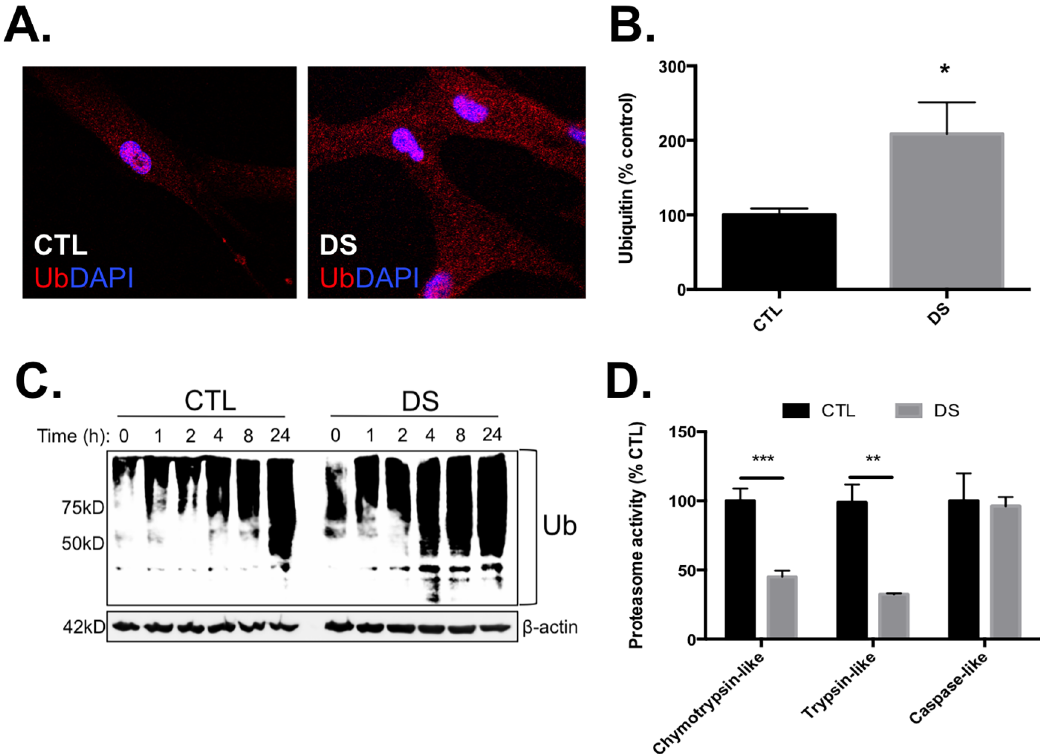
Fig 8. DS cells display an increasedabundance of ubiquitinated proteins and impaired proteasomal function. Untreatedfibroblasts from DS and CTL were stained for ubiquitinatedprotein and visualizedusing fluorescent microscopy (A). The amount of basal ubiquitinstaining was found to be significantly increasedin DS fibroblasts comparedto CTL (B), indicatingincreasedload of misfoldedproteinsin DS cells. Western blot analysesafter treatment with the proteasomal inhibitor,MG132 (5 μ M), show a more rapid increasein polyubiquitinated proteins (C) in DS comparedto CTL. Further investigation of proteasomal activity demonstrated that in DS fibroblasts there are significant decreases in both chymotrypsin-like and trypsin-like activity of the proteasome (D). N = 3, * P < 0.05, ** P < 0.01; *** P < 0.001.